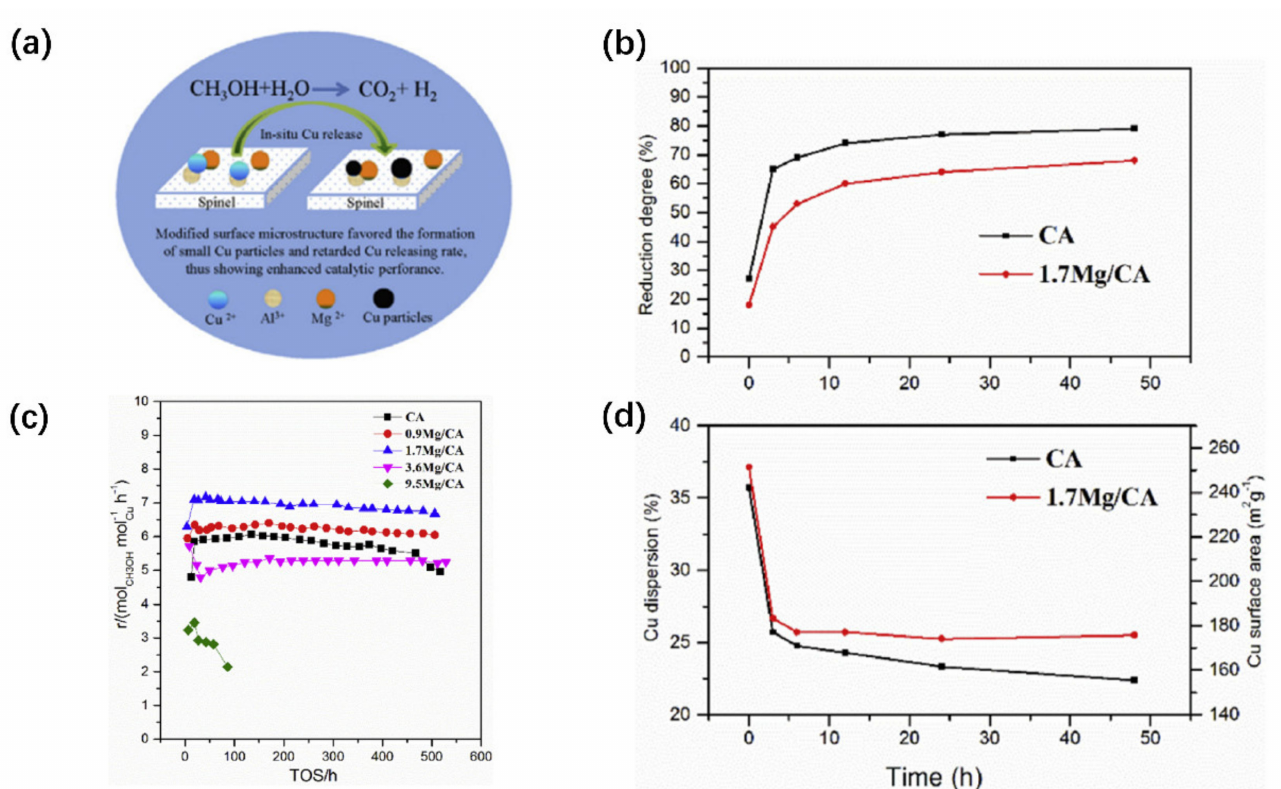
Figure 8. MgO-modified Cu-Al spinel oxide catalyst for methanol steam reforming: ( a ) Reaction process on catalyst; ( b ) the degree of reduction varying with the reduction time; ( c ) stability testing of original samples and Mg-doped catalysts; and ( d ) copper dispersion and surface area versus time. Reproduced with permission [102]. Copyright Elsevier,